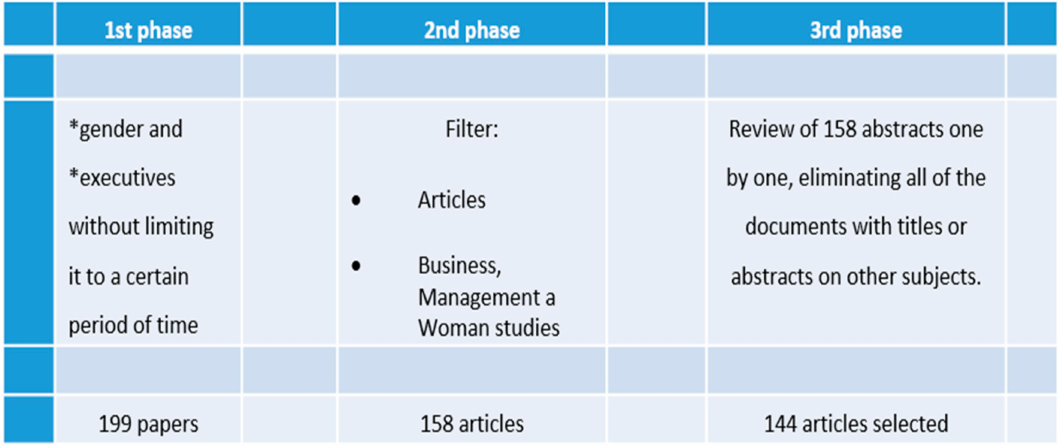
Figure 1. Outline of the methodology followed. * The Web of Science search included these